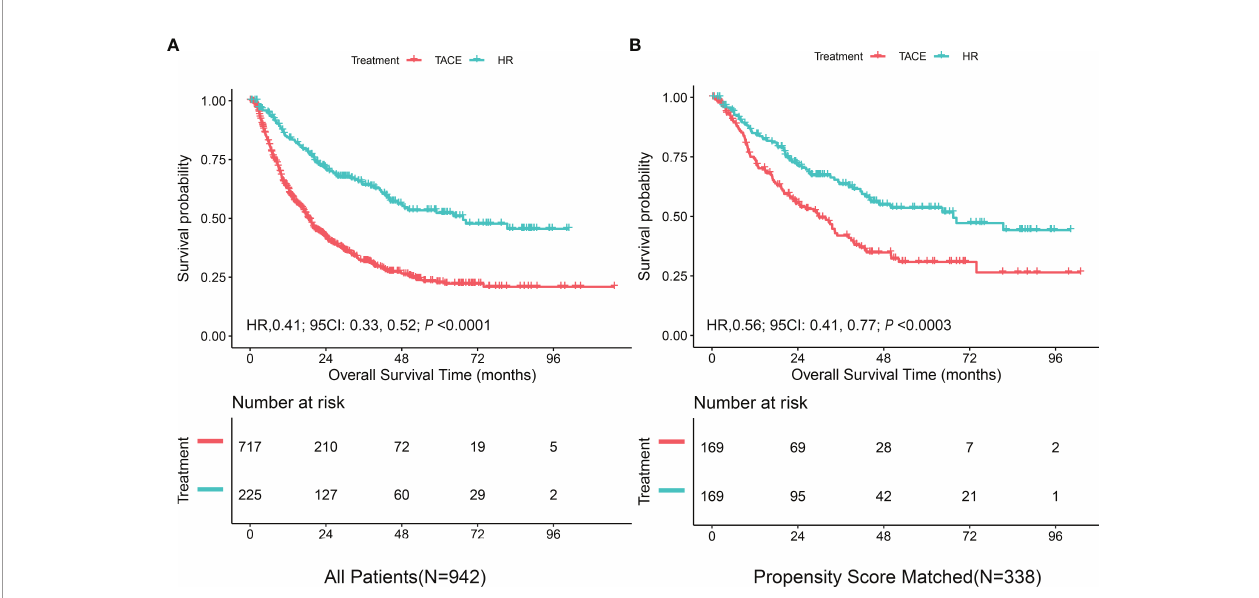
FIGURE 1 | Kaplan – Meier curves of overall survival in the derivation cohort strati fi ed by hepatic resection (HR) and transarterial chemoembolization (TACE). (A) All patients. (B) Propensity score-matched